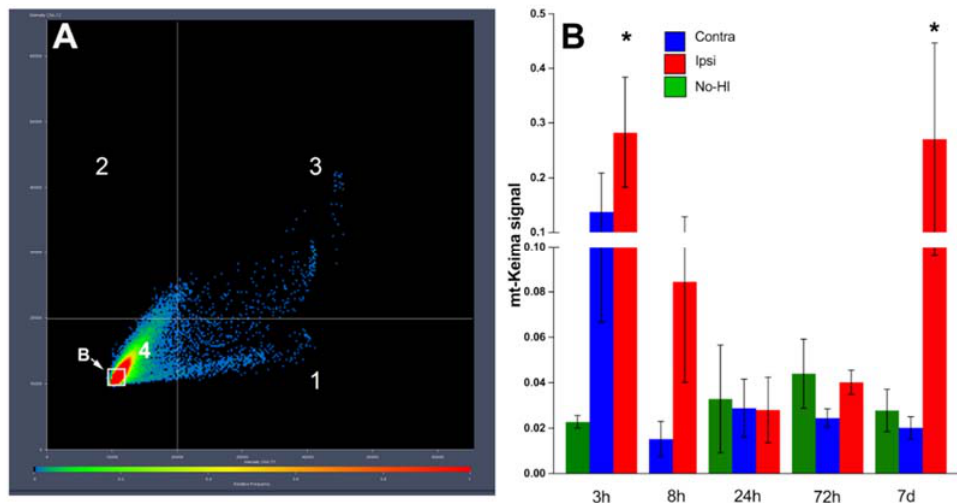
Figure 8. Assessment of mitophagy ( A ): mitophagy is quantified as the number of pixels in quadrant 1 divided by the total number of pixels. ((Quadrants 1 + 2 + 3 + 4) − B) where b is the background n = 3–6 mice/gp +/ − SEM. * p ≤ 0.05. ( B ): Statistics compared by Mann–Whitney Test with respective No-HI controls.